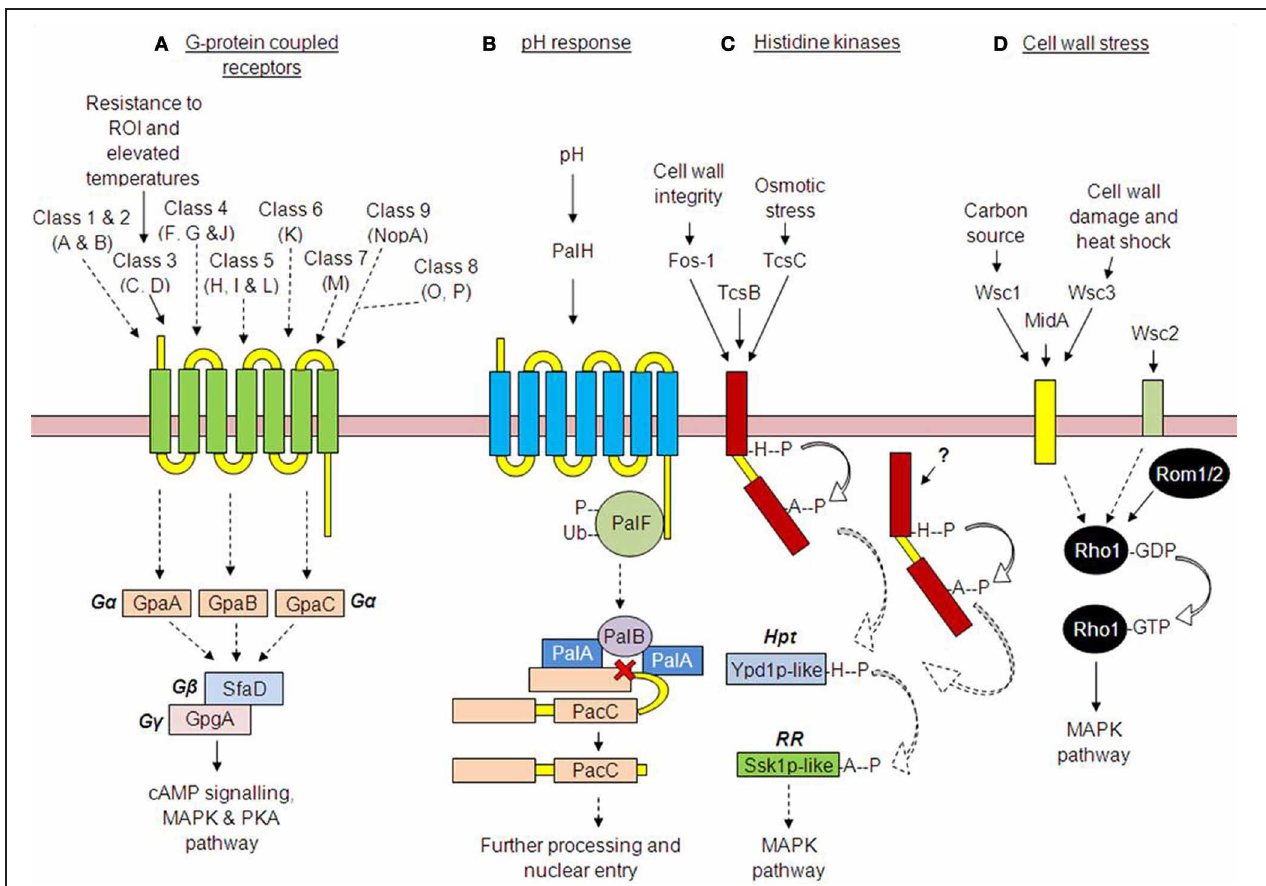
FIGURE 1 | Receptor-mediated signaling in Aspergillus fumigatus . (A) G-protein coupled receptor pathways —So far 15 GPCRs have been identified in A. fumigatus , though only two have been characterized (GprC and D). (B) The pH-response pathway —A shift from acidic to alkaline environmental pH is thought to be detected by the receptor PalH, mediating the phosphorylation, and subsequent ubiquitination of the C-terminally bound arrestin, PalF. This stimulates the proteolytic cleavage of the transcription factor PacC. PacC then undergoes further pH independent cleavage, before translocating to the nucleus. (C) The histidine kinase